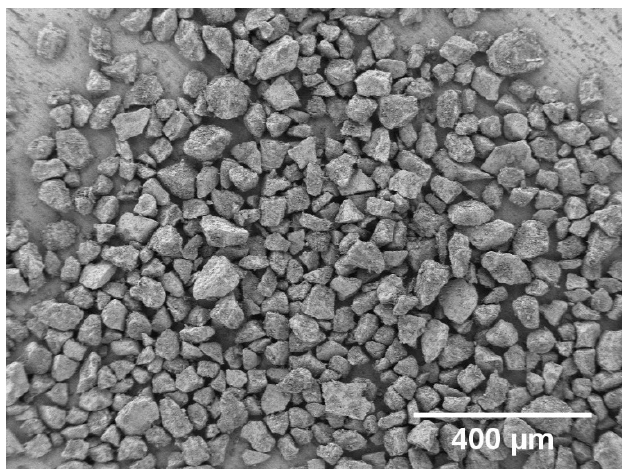
Figure 2. Scanning electron microscopy (SEM) image of the investigated bioactive glass (BG) granules prior to passivation depicted at a 200-fold magnification. The image was taken using a secondary electron detector, at a voltage of 1.5 kV and working distance of 5.1 mm. The reference bar refers to 400 µm.